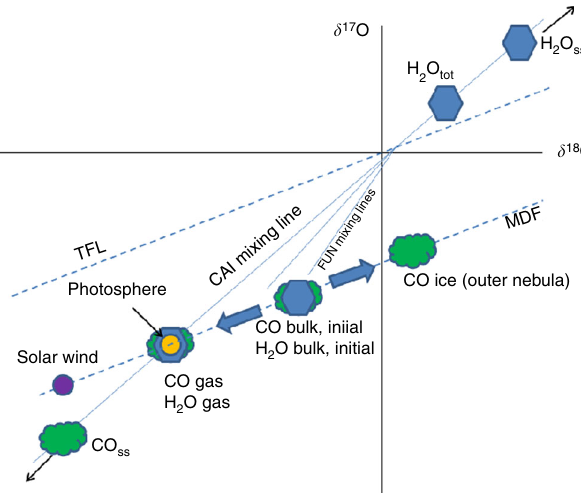
Fig. 8 An illustration of how CO condensation in the outer solar nebula could qualitatively affect O isotope reservoirs. Assuming that condensed CO remains in the outer nebula, and is not mixed back into the O reservoir from which planets were formed, then there will be a mass-dependent enrichment in the CO ice relative to the bulk initial CO from the parent cloud. If CO self-shielding yielded H 2 O at the other end of the mixing line (H 2 O ss ), the dissociated CO gas must have been on or close to the CAI mixing line. Residual (undissociated) CO gas (CO ss ) would have been highly depleted in 17 O and 18 O (refs. 7,31 ). If the initial bulk reservoir of H 2 O was isotopically similar to CO initial bulk, then it too must have been mass- dependently fractionated until it resided on or near the CAI mixing line. This seems an unlikely occurrence, suggesting that perhaps the CO condensed phase was not large enough to substantially alter the O (and C isotopes) of the CO and from which planets were formed. Mixing lines for FUN inclusions are also shown, but the mass-dependent displacement that de fi nes the lower end of the FUN inclusion mixing lines 67 are mostly likely derived from melting and evaporation of precursor CAIs 68 , and not from the bulk initial CO and H 2 O reservoirs